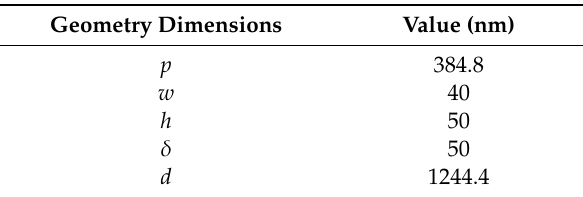
Table 1. Designed sensor geometry (See Figure